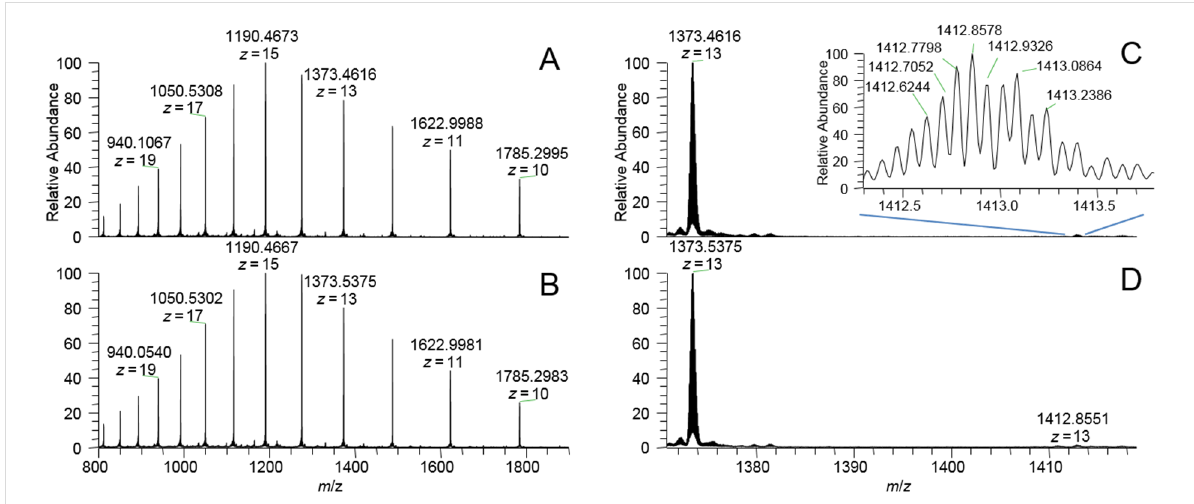
Figure 6: Intact protein ESIMS spectra of FimH tr labeling with diazirine derivative 3 with (A) 50% acetonitrile or (B) 10% DMSO additive. (C) Minor peak at 1412.8578, as part of spectrum A, representing the covalently bound label. Zoom into the signal at charge state +13. Labeling yield calcu- lated from peak intensities compared to the corresponding signal of unlabeled peptide: 1.41% (50% acetonitrile). (D) Minor peak at 1412.8551, as part of spectrum B, representing the covalently bound label. Labeling yield calculated from peak intensities compared to corresponding signal of unla- beled peptide: 1.55% (10% DMSO). The theoretically expected mass of labeled FimH tr is 1412.9333 Da. The fact that the most abundant isotope was not 1412.9333, but 1412.8578 and 1412.8551 Da is simply due to the high signal to noise ratio of the spectra as a result of low labeling